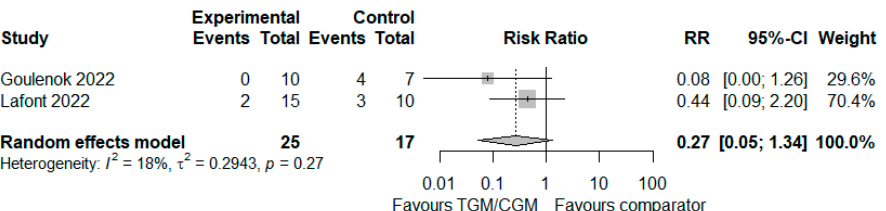
Figure 10. Proportion of patients who needed oxygen therapy (TGM/CGM vs. comparator). CI, confidence interval; RR, risk ratio; TGM/CGM, tixagevimab/cilgavimab.